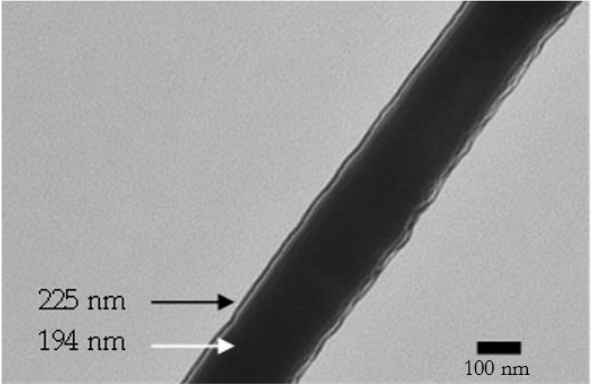
Figure 5. TEM image of a coaxial nanofiber with a P3HT/PS (0.4 wt.%/7 wt.%) core and a BBL (0.39 wt.%) shell. This nanofiber was the smallest one examined. The scale bar is 100 nm.